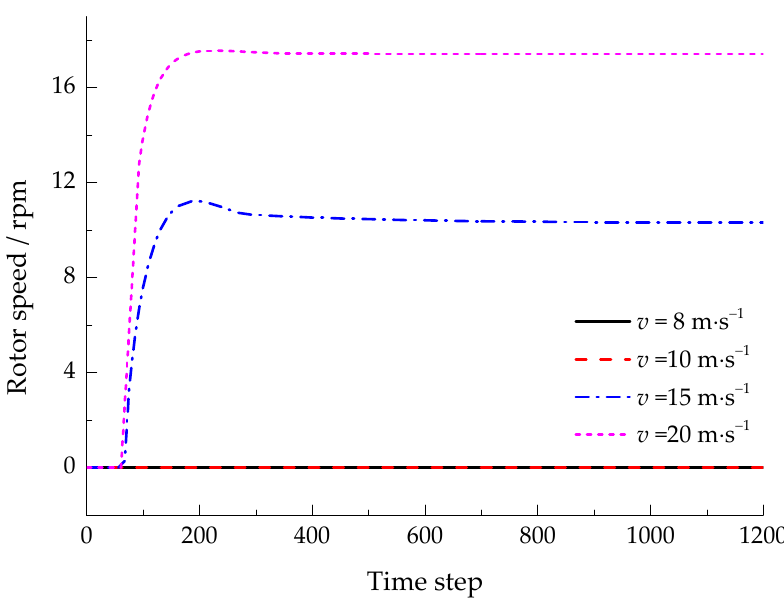
Figure 10. Variation of the blade pitch angle in terms of the time step for various wind speeds.